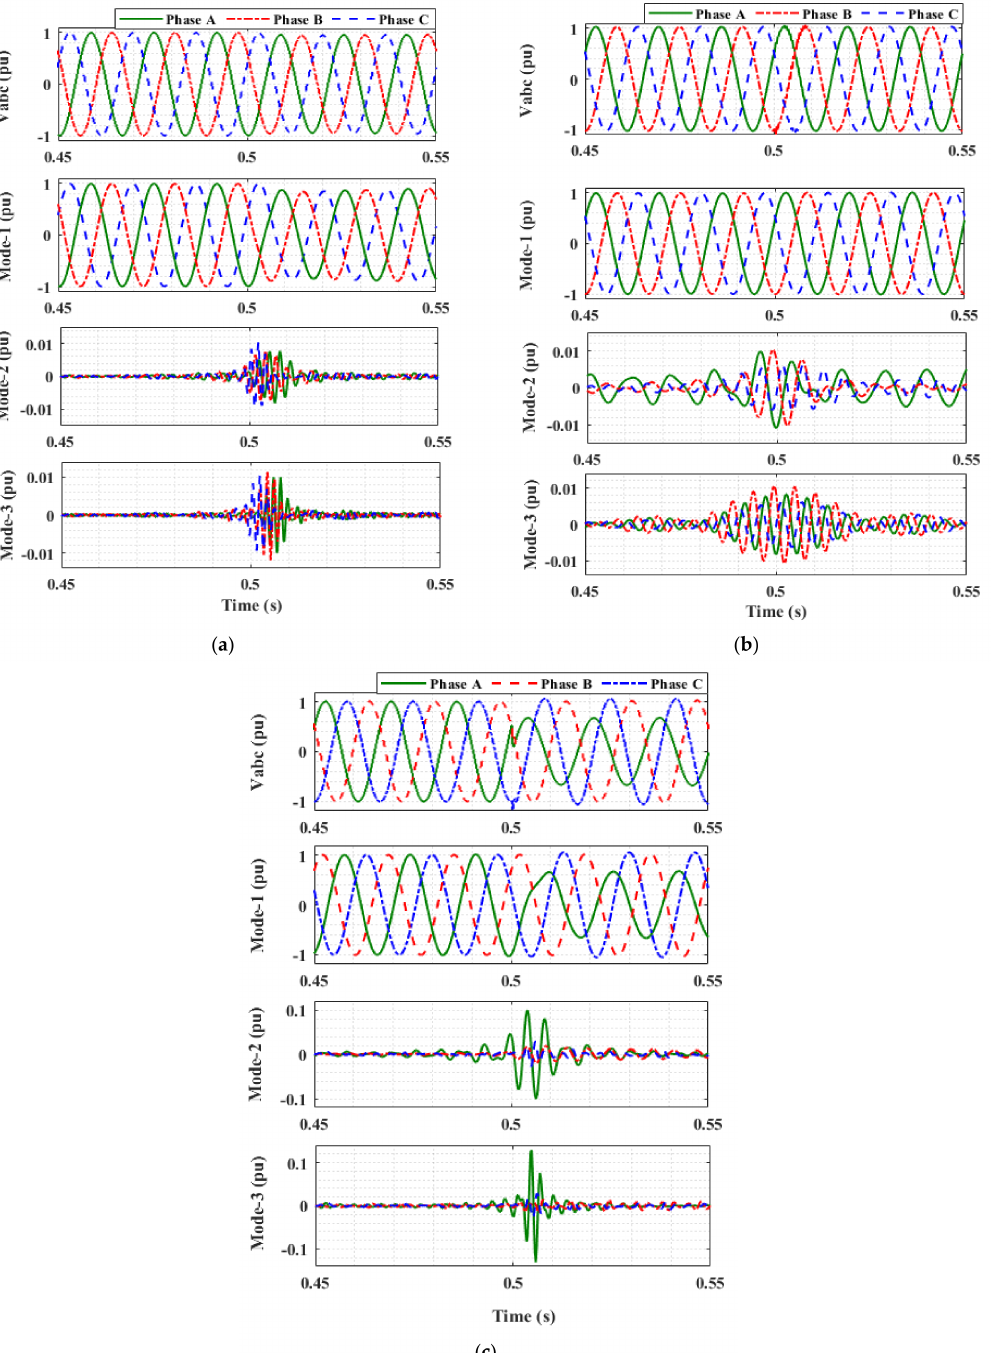
Figure 2. Three-phase voltage signal and its EMs during: ( a ) Islanding event. ( b ) Capacitor switching. ( c ) AG